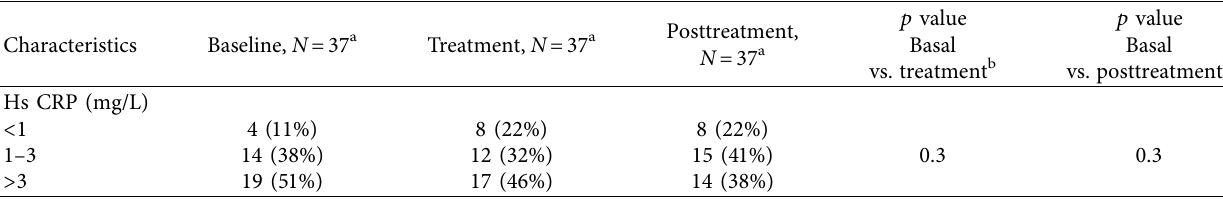
Table 3: Hs-CRP values per